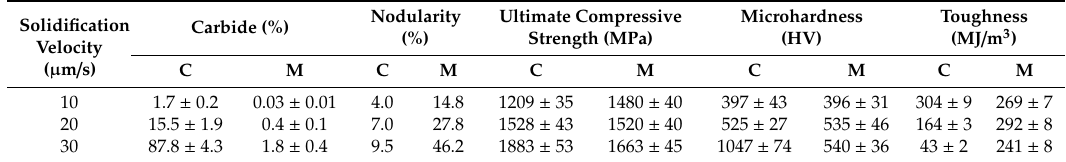
Figure 2. Engineering stress–strain curve for samples processed at varying solidification velocities for samples from ( a ) batch “C” (showing the effect of increasing carbide percentage resulting in a transition from ductile to brittle behavior) and ( b ) batch “M” (showing the effect of increased nodularity resulting in more ductile behavior). The curves were obtained under compression. Table 3. Microstructure parameters and compression properties.